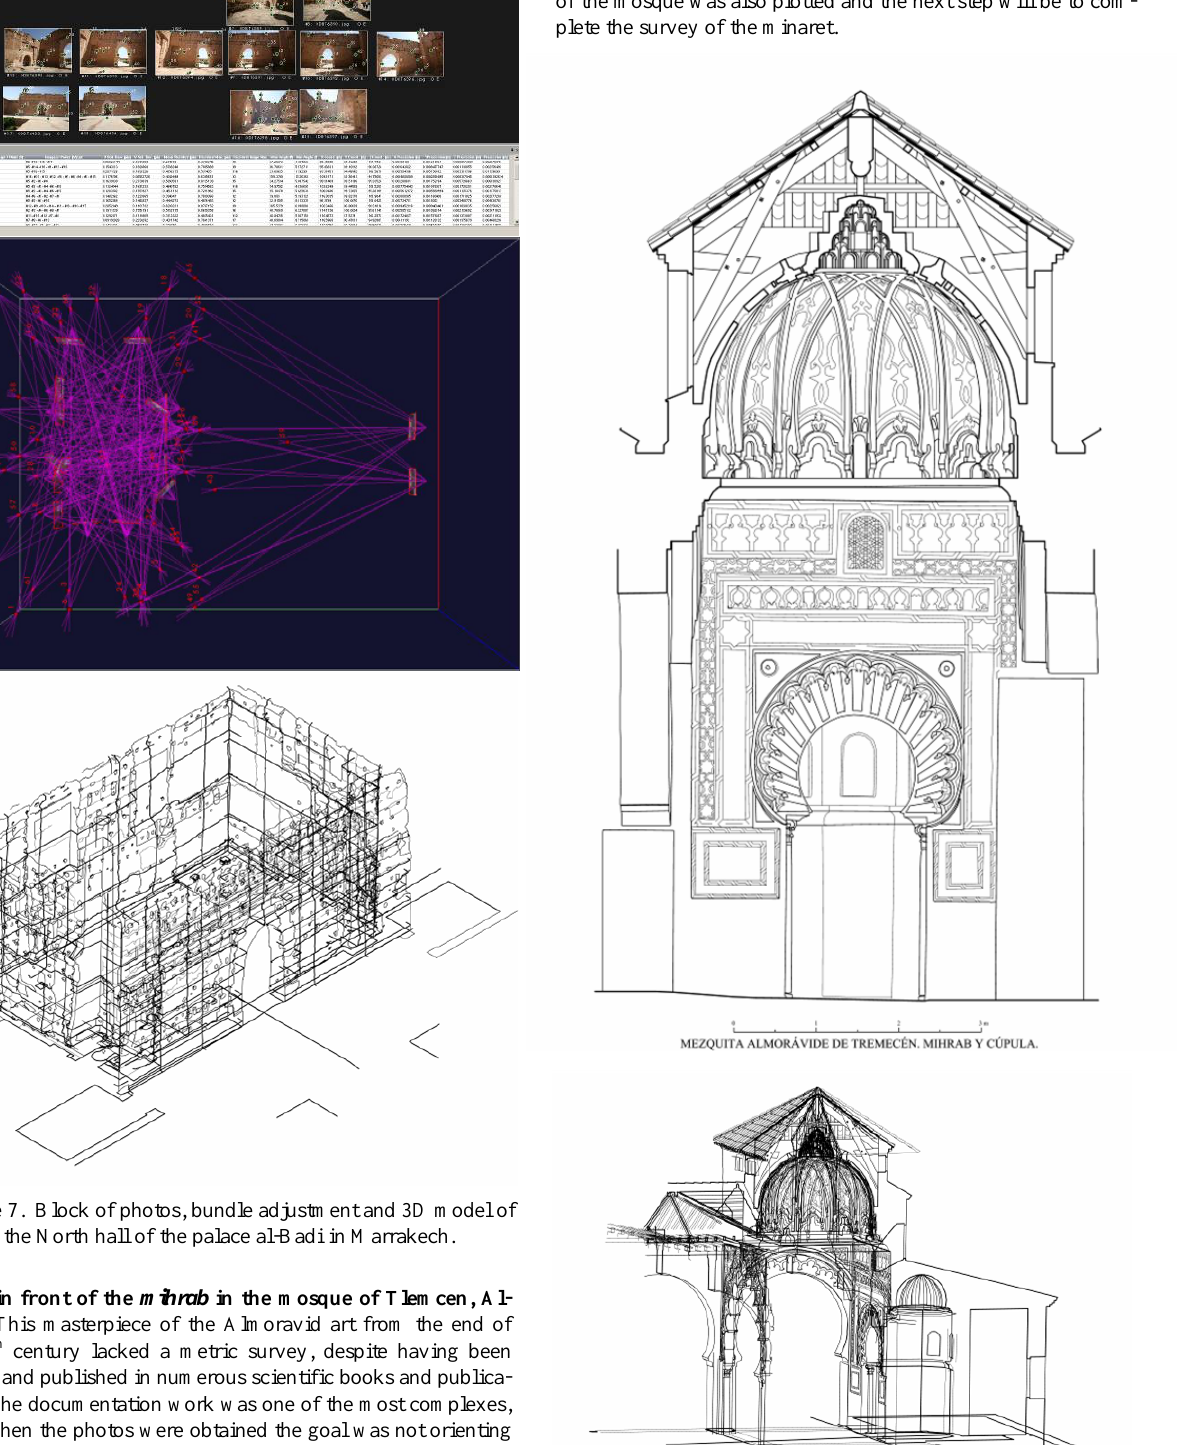
Figure 8. Cross section and 3D model of the dome beside the mihrab of the great mosque of